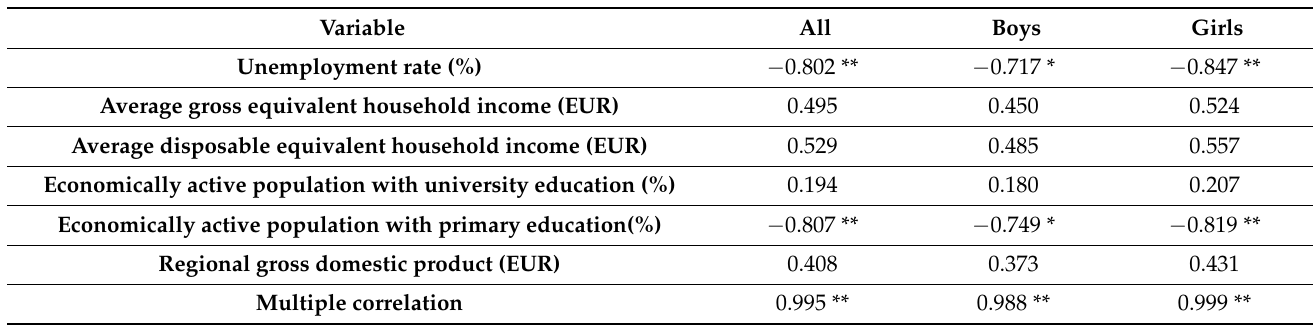
Table legend: AVG—the arithmetic average; STD—standard deviation; Min—minimum value in the group; Max—maximal value in the group; r stab —the reliability (stability) coefficient of the test. Table 2. Results of correlation analyses between SEIs and overall MP (T-scores), and of multiple correlations, at the level of self-governing regions.